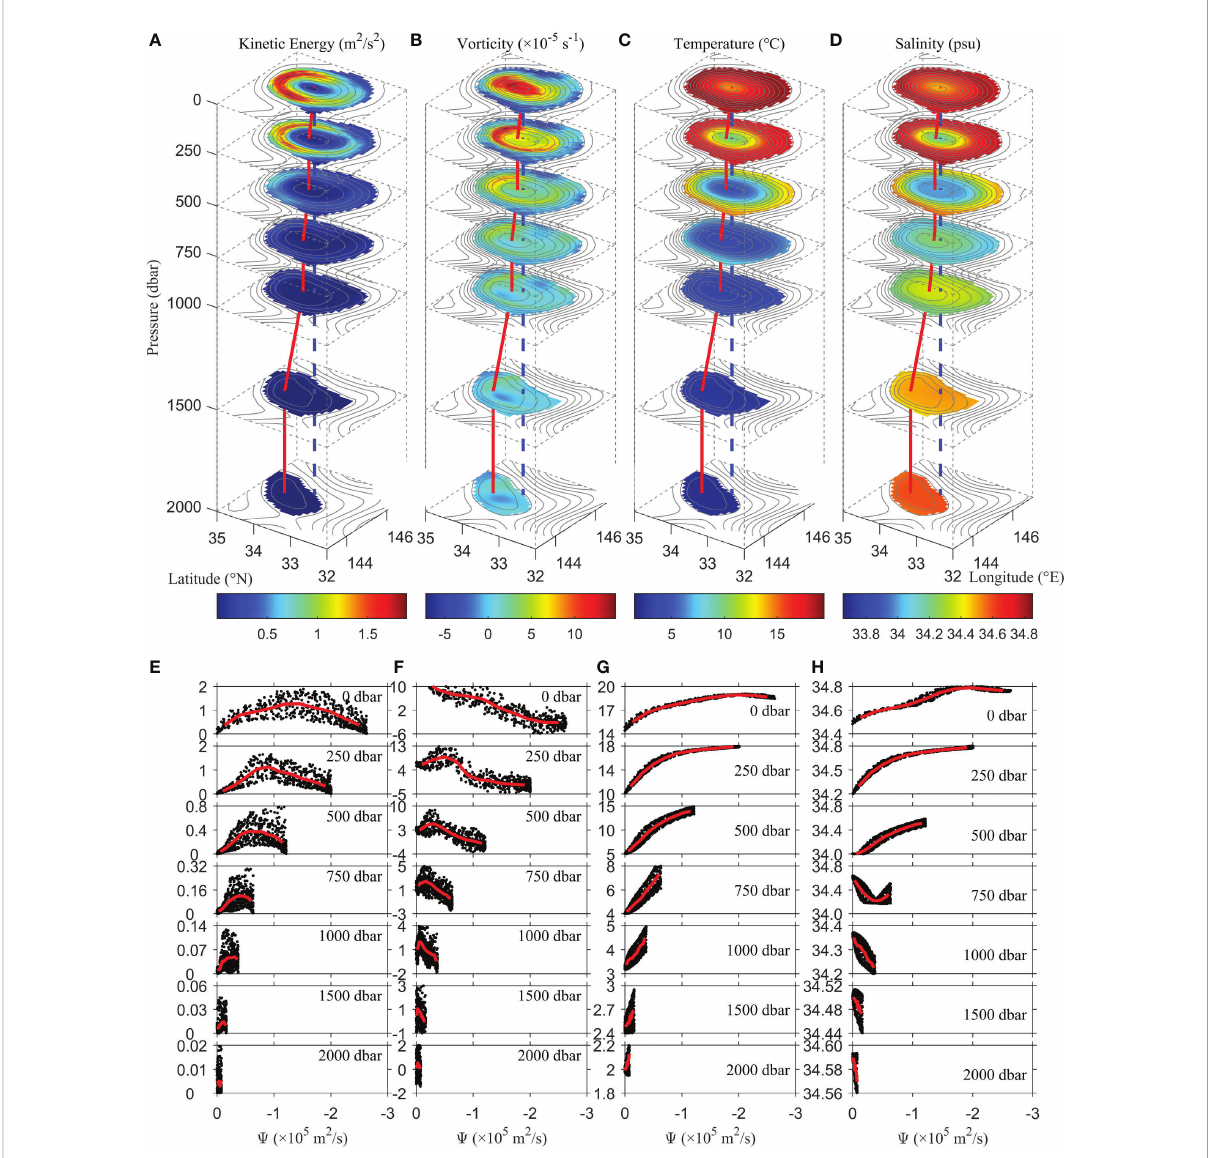
Three-dimensional structure of (A) eddy kinetic energy ( 1 ( u 2 + v 2 )), (B) vorticity ( z = ∂ v ∂ x − ∂ u ∂ y ), (C) temperature, and (D) salinity on February 1, 2 2005 at 0, 250, 500, 750, 1,000, 1,500, and 2,000 dbar. Blue dashed line marks the vertical projection of the surface eddy center, and red solid line connects the eddy centers in the layers. Gray lines indicate the contours of the stream function of each layer relative to the eddy center. (E – H) Black dots correspond to the stream function values at depth with respect to kinetic energy, vorticity, temperature, and salinity. Red solid line indicates the mean value at the stream function per 1 × 10 -6 m 2